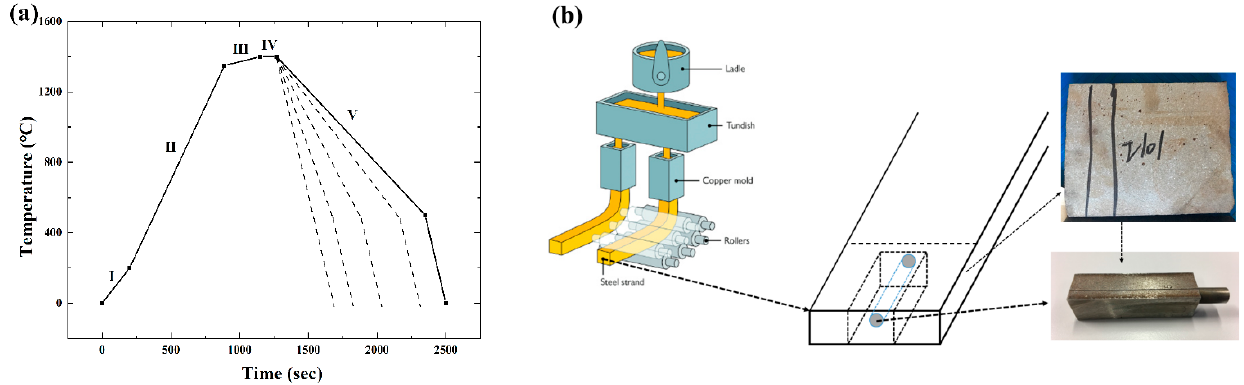
Figure 2. ( a ) Temperature profile of concentric HTCM experiments. I—Stabilizing stage, II—Fast heating stage, III—Slow heating stage, IV—Holding stage, and V—Cooling stage. Different dot lines represent different cooling rates; ( b ) schematic diagram and pictures of S32101 DSS samples.